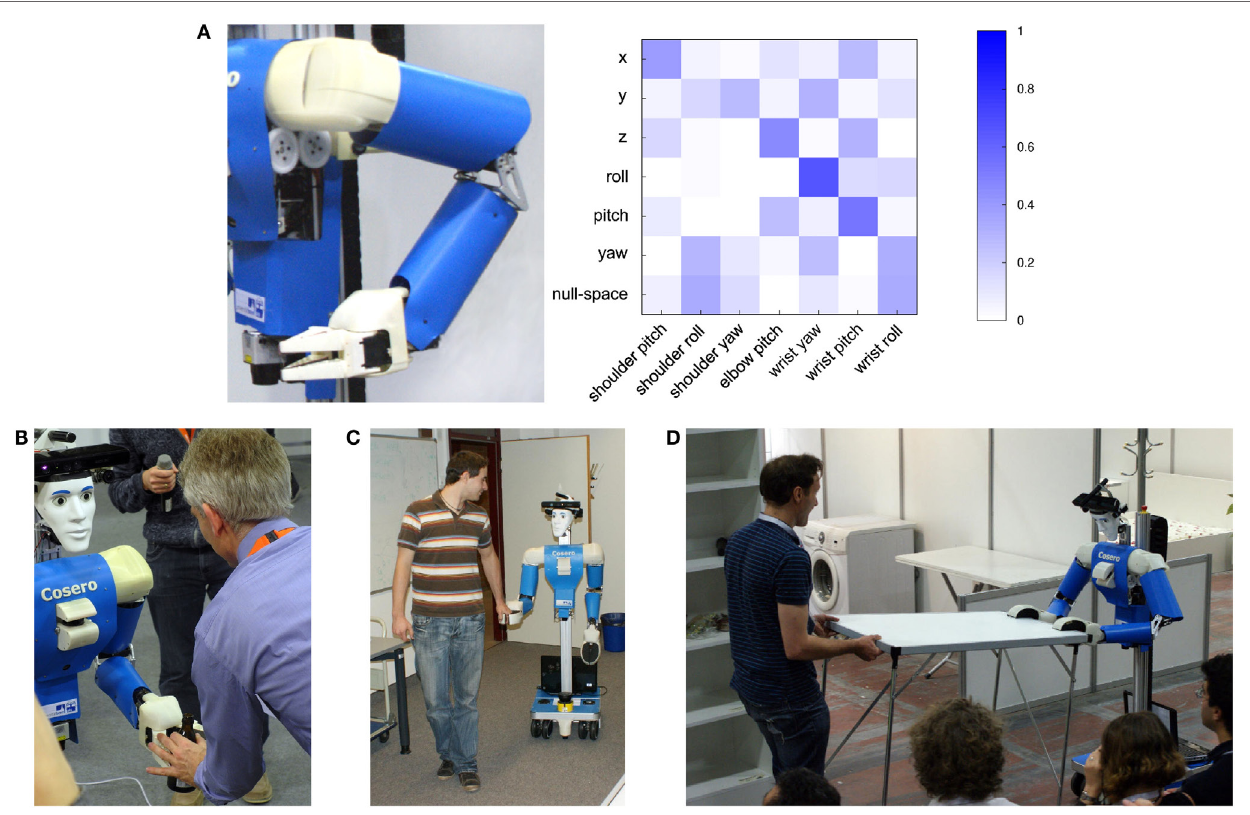
FIgURe 4 | compliant arm control (Stückler and Behnke, 2012) . (A) Activation matrix for compliant control in an example arm pose. The task-space dimensions correspond to forward/backward (x), lateral (y), vertical (z), and rotations around the x-axis (roll), y-axis (pitch), and z-axis (yaw); Examples for use of compliance in physical human–robot interaction: (B) object hand over from robot to user signaled by the user pulling on the object. (c) Cosero is guided by a person. (D) Cosero follows the motion of a person to cooperatively carry a